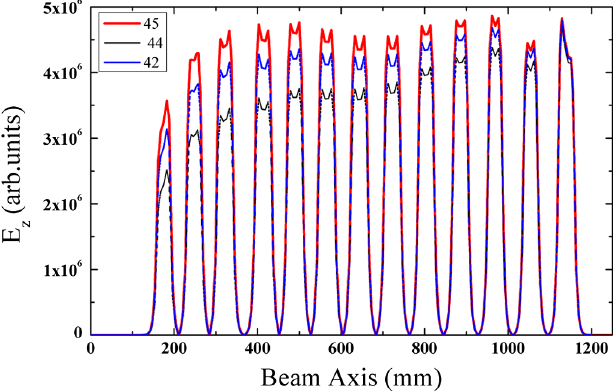
FIG. 39. Dependence of the longitudinal component of the electric field in the first section of the second FAIR resonator as a function of the inclination of the first stem (parameter S of Fig. 38).